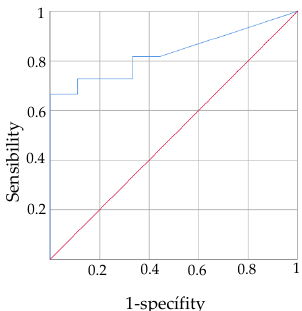
Figure 2: ROC curves predictive validity PASS in acute stage for functionality in chronic stage